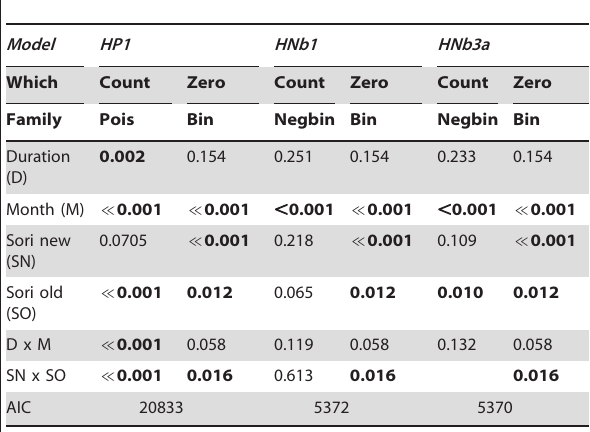
Table 1. Hurdle model